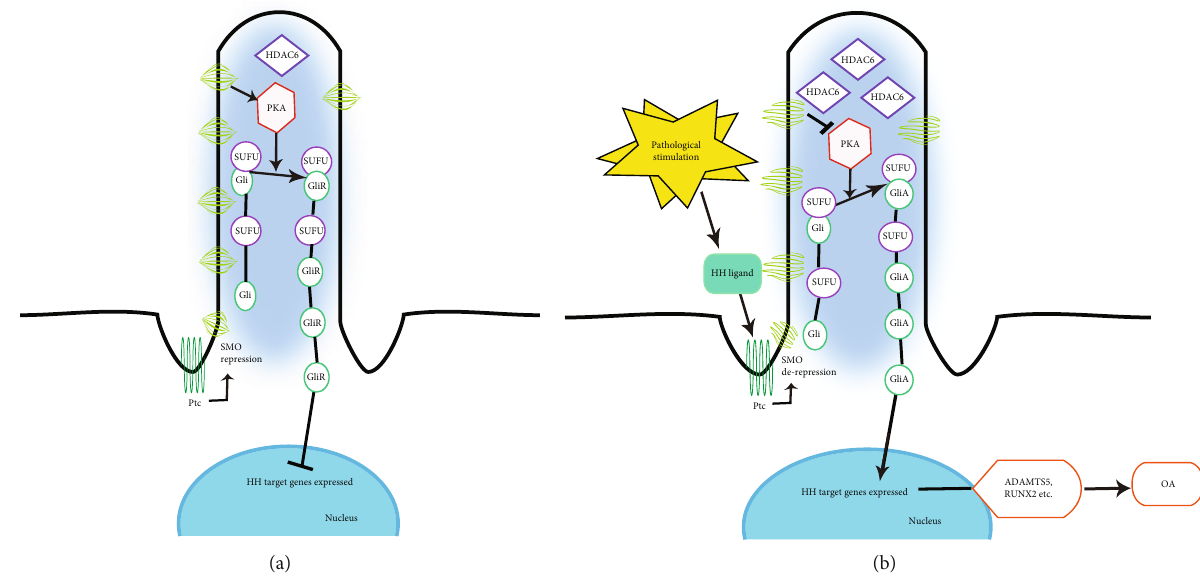
Figure 2: A brief diagram of Hh signaling under pathological stimuli. Histone deacetylase 6 (HDAC6) is a tubulin deacetylase that regulates the length of the primary cilia. Under normal conditions, the expression of HDAC6 maintains the length of the primary cilia. When the Hh ligand is not activated, Ptc inhibits SMO activity, puts it in a closed state, increases PKA activity, promotes phosphorylation of the SuFu and Gli complex, processes into a truncated repressor form of Gli repressor (GliR), and suppresses Hh target genes in the nucleus (a). Upon pathological stimulation, HDAC6 expression is abnormally increased, promoting primary ciliary elongation and activating the Hh signaling pathway. When the Hh ligand binds to the Ptc receptor to release inhibition of SMO, Smo inhibits Gli processing, causing the full-length Gli activator (GliA) to enter the nucleus to activate relevant target genes such as ADAMTS5 and RUNX2, which causes changes in